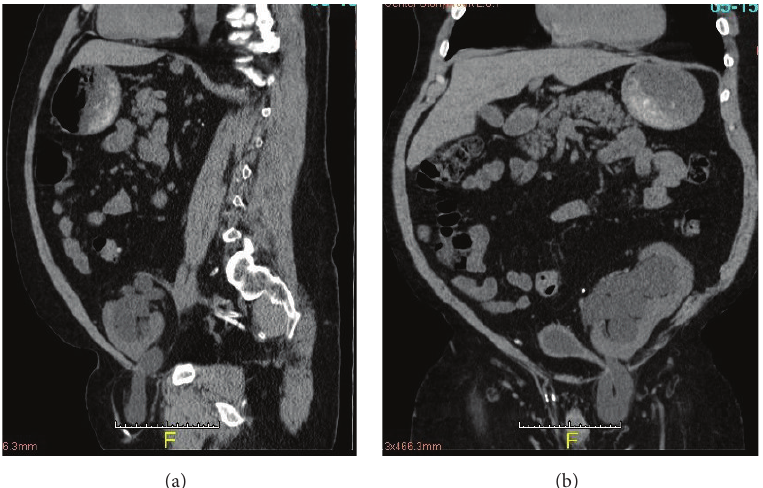
Figure 1: Noncontrast CT abdomen pelvis in sagittal (a) and coronal (b) views revealing transplant ureter within inguinal hernia resulting in hydroureteronephrosis.